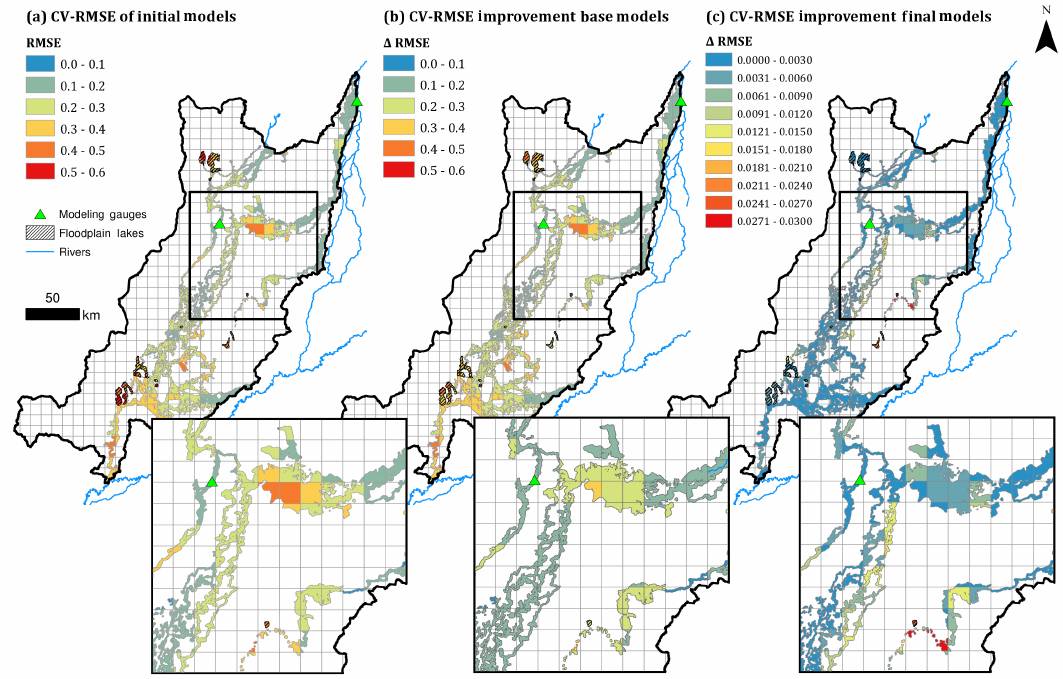
Figure 8. (a) CV-RMSE of the initial models of the floodplain and floodplain-lake surface water category in the Paroo sub-region and improvement in CV-RMSE after accounting for the (b) LDV (base models) and (c) APV (final